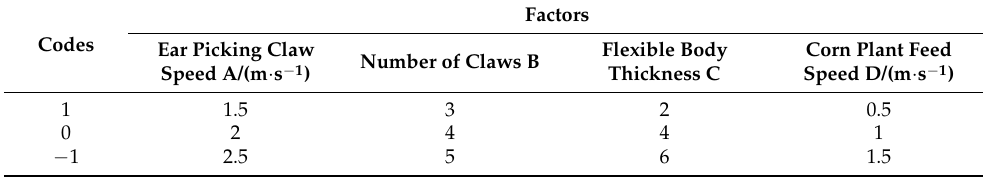
Table 3. Codes of the experimental factors.